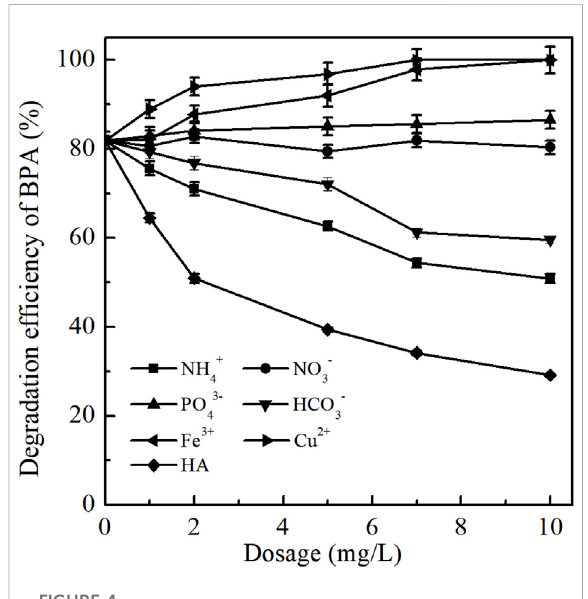
FIGURE 4 Effects of co-existing interfering ions on BPA degradation. (Experimental conditions: [BPA] 0 = 1.00 mg/L; ozone dosage 0.25 mg/L; initial solution pH = 7.0; temperature = 25 ± 1 ° C;